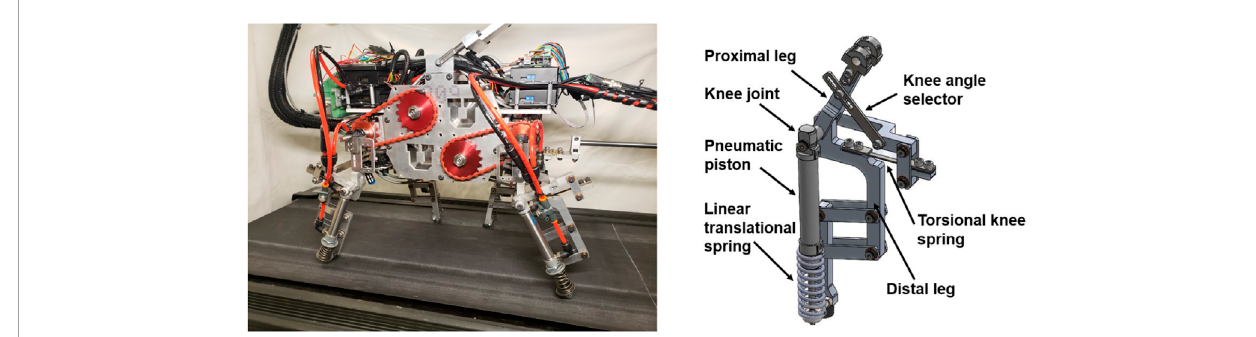
FIGURE 1 Left: A side view of UPed Gurney et al. (2023). Right: A schematic of one of the robot’s legs designed in solid works. Used with permission of ASME, from [UPed: A Quadruped Robot Platform to Study Directional Leg Compliance, Gurney and Filsoofi et al., vol 15, no 1, 2023]; permission conveyed through Copyright Clearance Center, Inc.